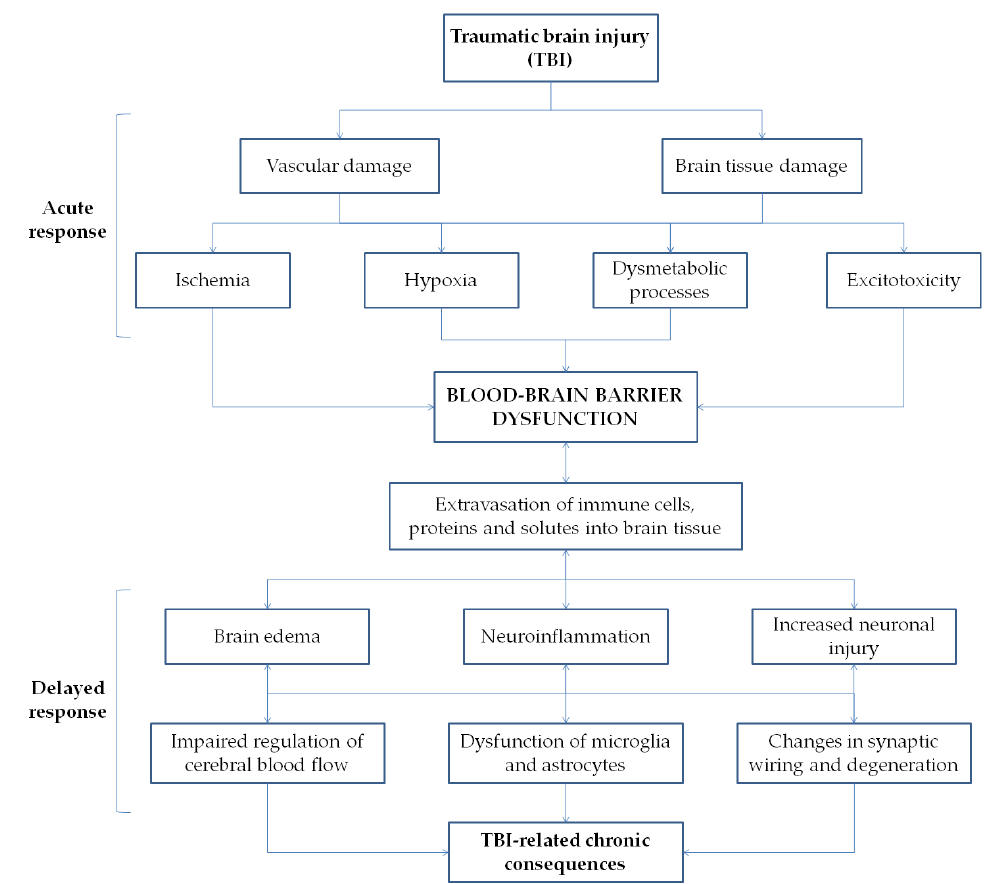
Figure 1. Pathophysiological events in traumatic brain injury (TBI). The primary direct injury includes vascular and brain tissue damage, associated with ischemia, hypoxia, dysmetabolic processes, and neuronal excitotoxicity. The dysfunction of the blood–brain barrier resulting from direct damage leads to extravasation of immune cells, protein, and solute into brain tissue promoting further BBB damage, cerebral edema, neuroinflammation, and neuronal damage. These mechanisms trigger a cascade of subsequent events including impaired regulation of cerebral blood flow, dysfunction of microglia and astrocytes, changes in synaptic wiring, and neuronal degeneration, which perpetuate neuroinflammation and brain tissue damage.